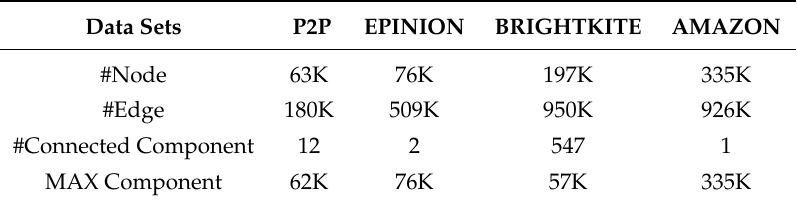
Table 2. Data set for our experiment.